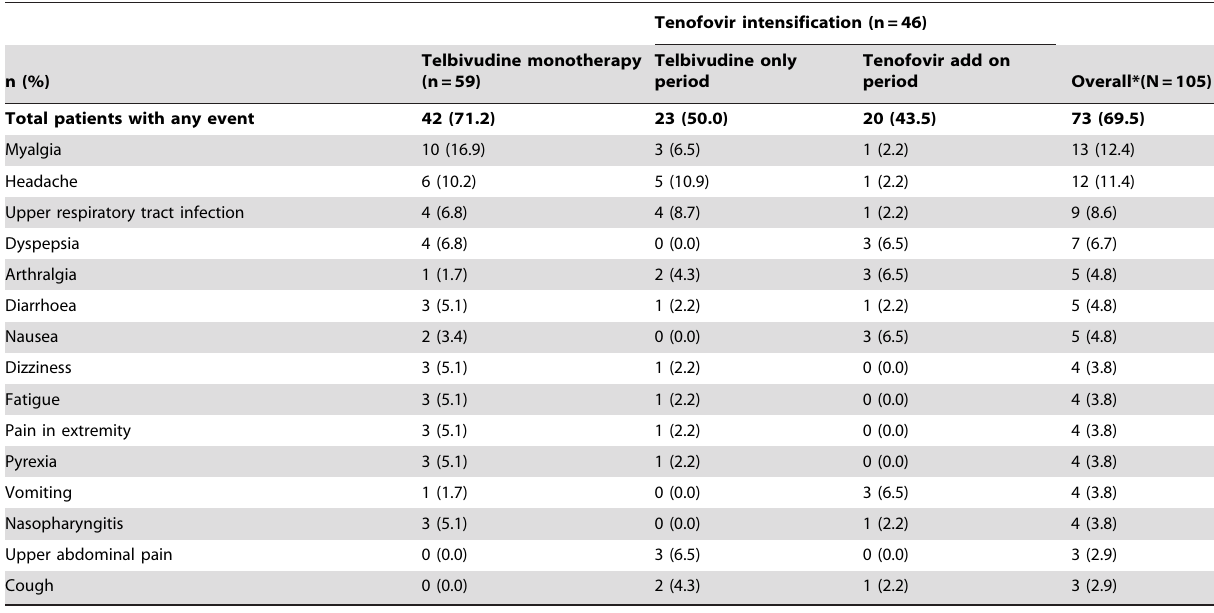
Table 3. Most common ( $ 5%) all-cause adverse events through Week 52 (safety